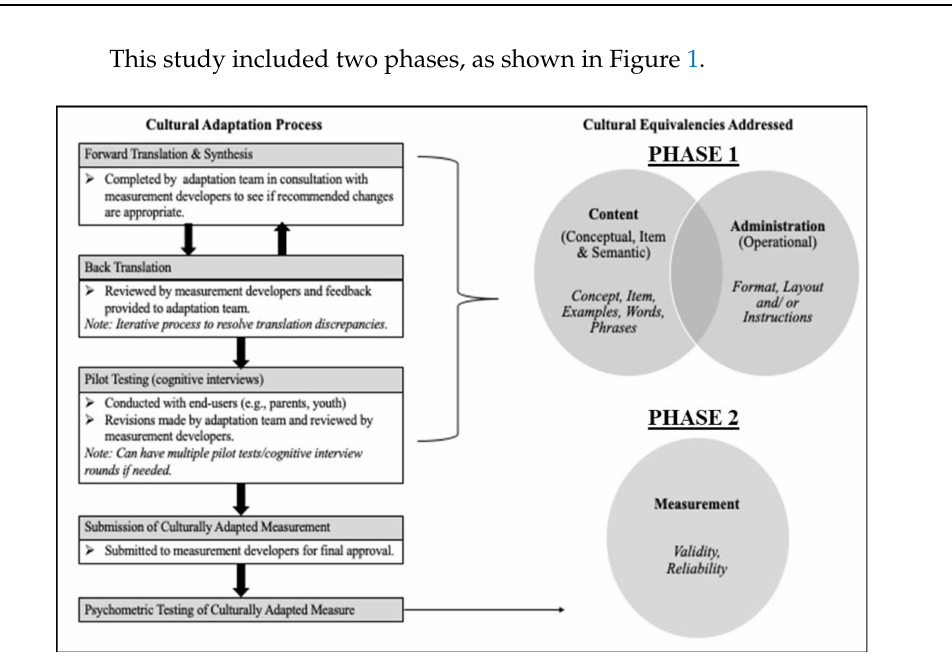
Figure 1. The adaptation process to achieve cultural equivalency for pediatric participation mea- sures